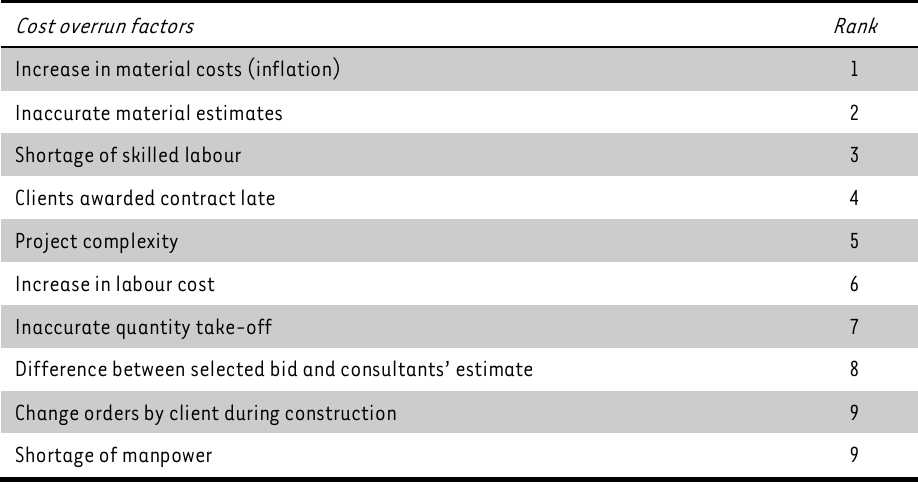
TABLE 6: Factors reported to have caused cost overruns of world-cup 2010 stadia Cost overrun factors Rank Increase in material costs (inflation) 1 Inaccurate material estimates 2 Shortage of skilled labour 3